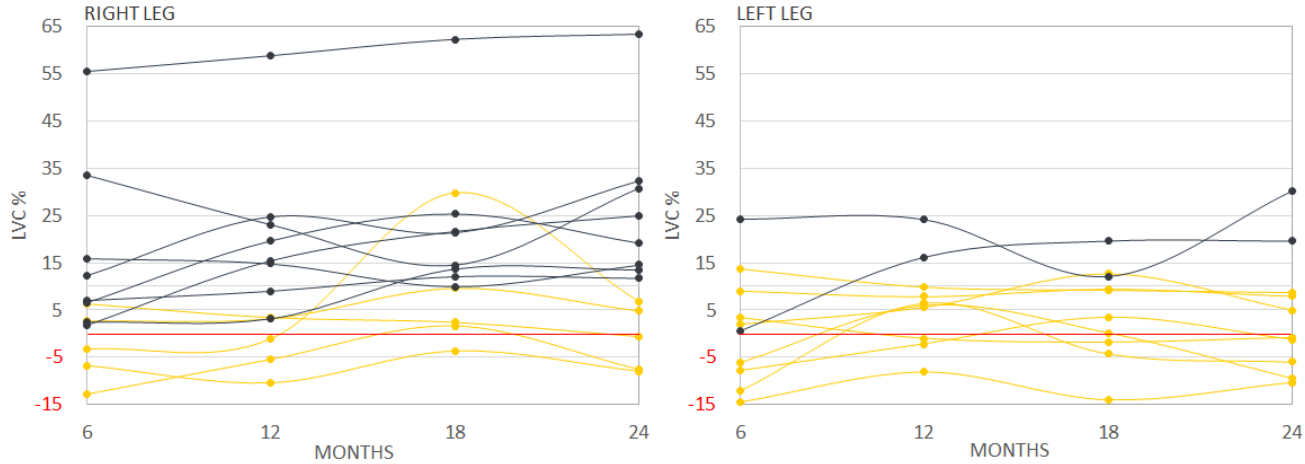
Figure 3. Individual fluctuations of objectively assessed LVC in patients subjectively reporting LLL. Yellow lines: patients without objective LLL; Black lines: patients with objective LLL (all grades). LVC: limb volume change; LVI: limb volume increase.